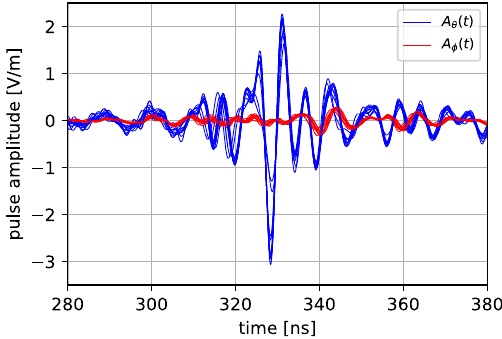
Fig. 8 Polarization of starting pulses against the launch angle. The launch angle at which each station can receive signals from the SPICE drop is indicated below. Figure adapted from Ref.